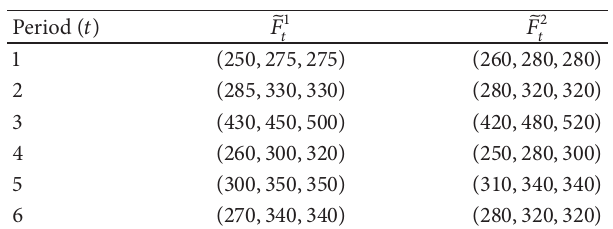
Table 7: Fuzzy demand.